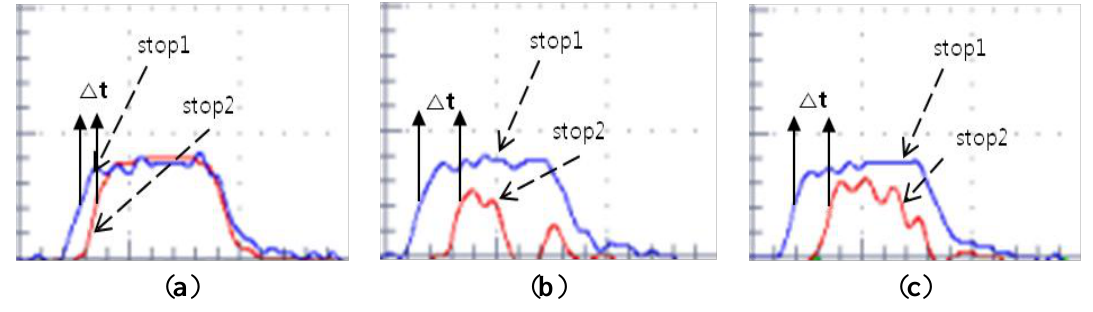
Figure 9. Detected pulse shape at Node 1 (26 cm, 0 deg). ( a ) 26.0492 cm at 0 deg (Normal case), ( b ) 49.3872 cm at 0.3 deg, ( c ) 64.6046 cm at 0.4